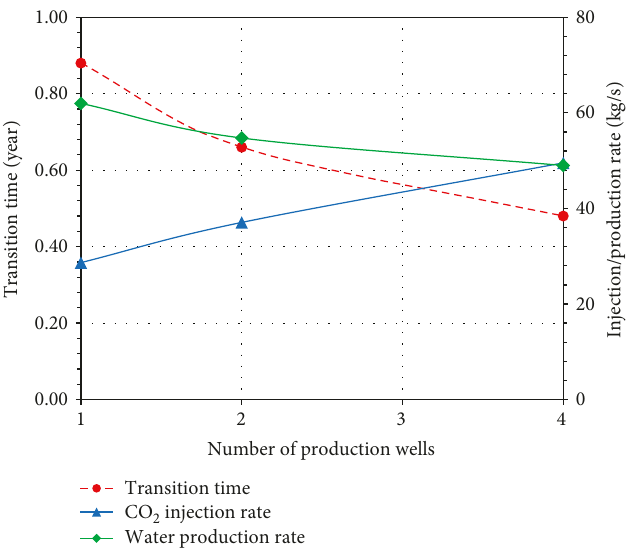
Figure 16: In fl uence of the number of production wells on the transition time point, injection rate, and production rate.